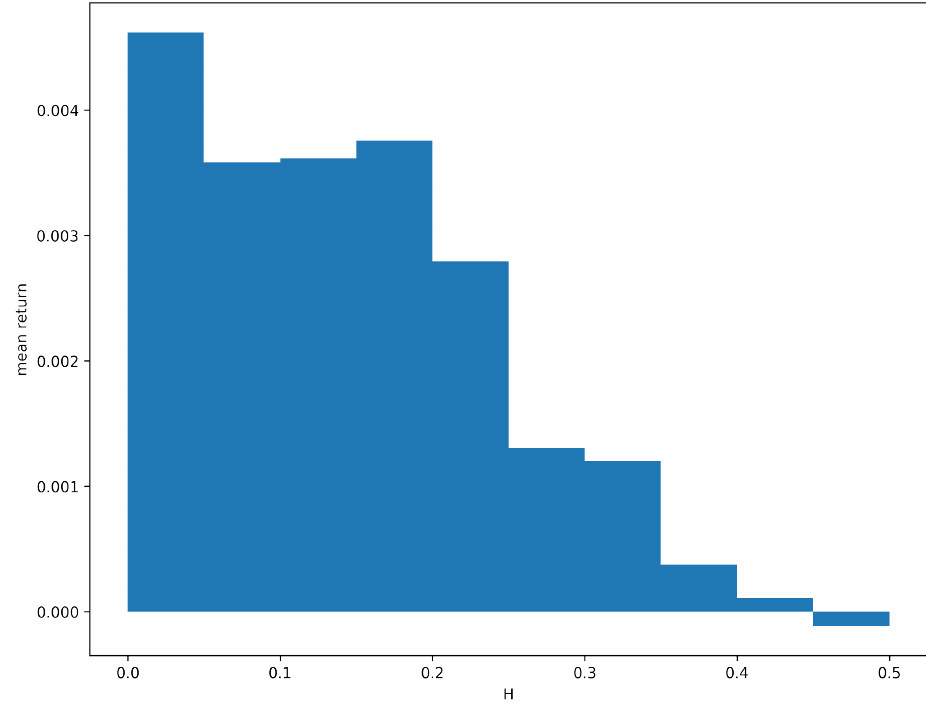
Figure 2. Comparison between the value of H and the mean return of the portfolios for the pe- riod